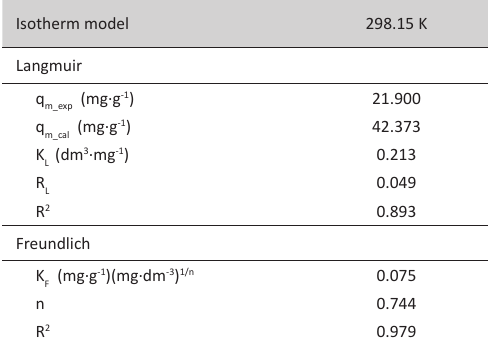
tABle 3. Isotherm parameters for the removal of MB by poplar sawdust at 298.15 K. Isotherm